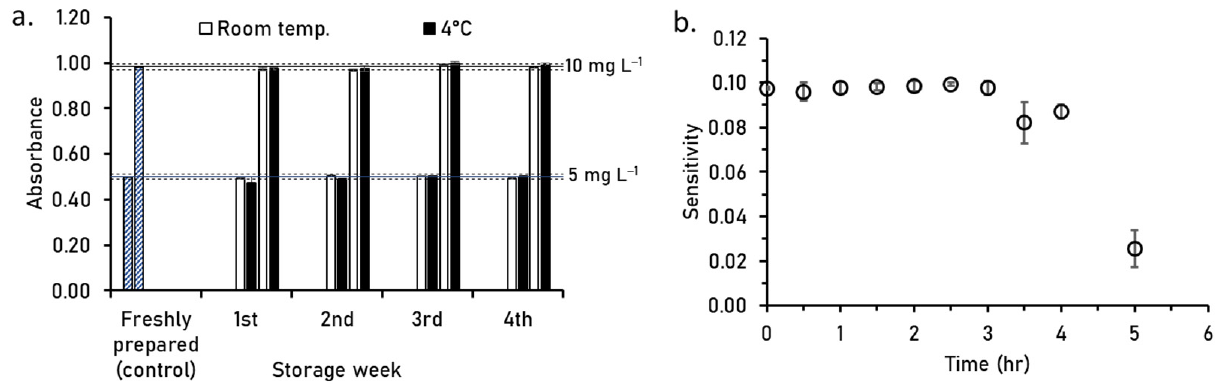
Figure 6. Investigation of stability of ( a ) standard paraquat solution and ( b ) alkaline sodium dithionite reagent.